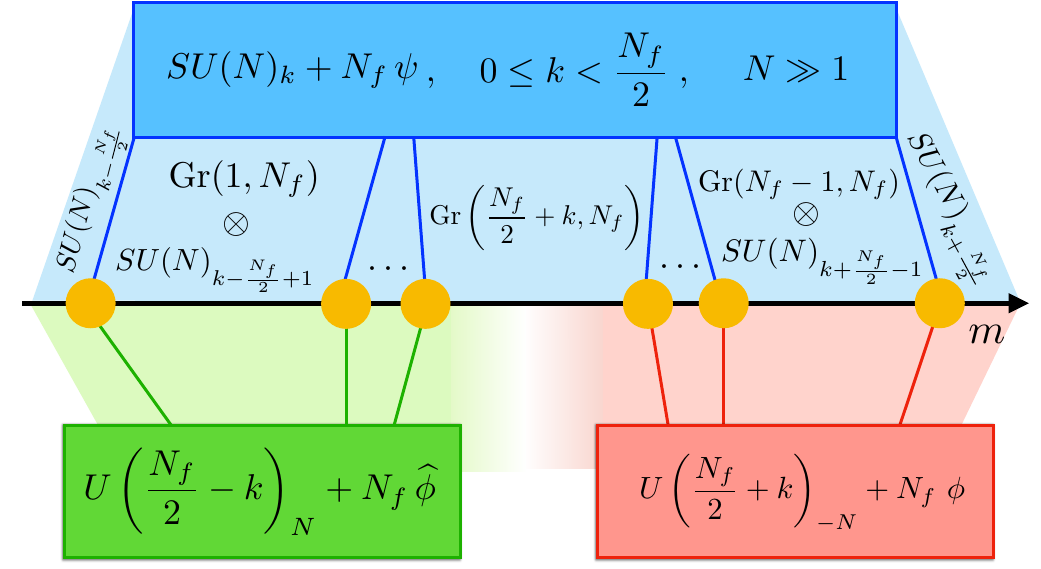
N f Figure 10 . Phases of large- N QCD as a function of the 3 (shown in blue) with 0 (cid:20) k < 2 (cid:13)avor-singlet mass m . There are N f + 1 phases, which generically contain both NG bosons (with Grassmannian target spaces) associated with di(cid:11)erent patterns of (cid:13)avor-symmetry breaking, as well as a Chern-Simons TQFT in the deep IR. There are N f (cid:12)rst-order phase transitions indicated by yellow dots. The same phases and transitions are captured by the two mutually non-local bosonic dual theories (shown in green and red), if their respective scalar potentials are chosen